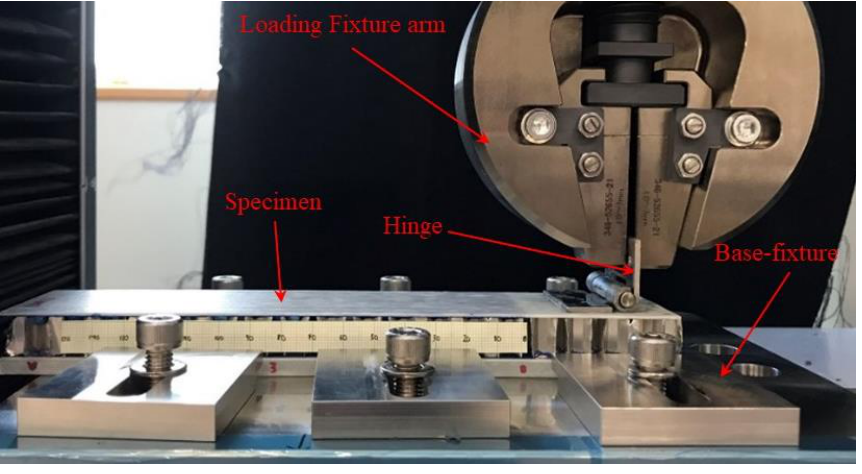
Figure 9. SCB test fixture along with the Mode-I loading.